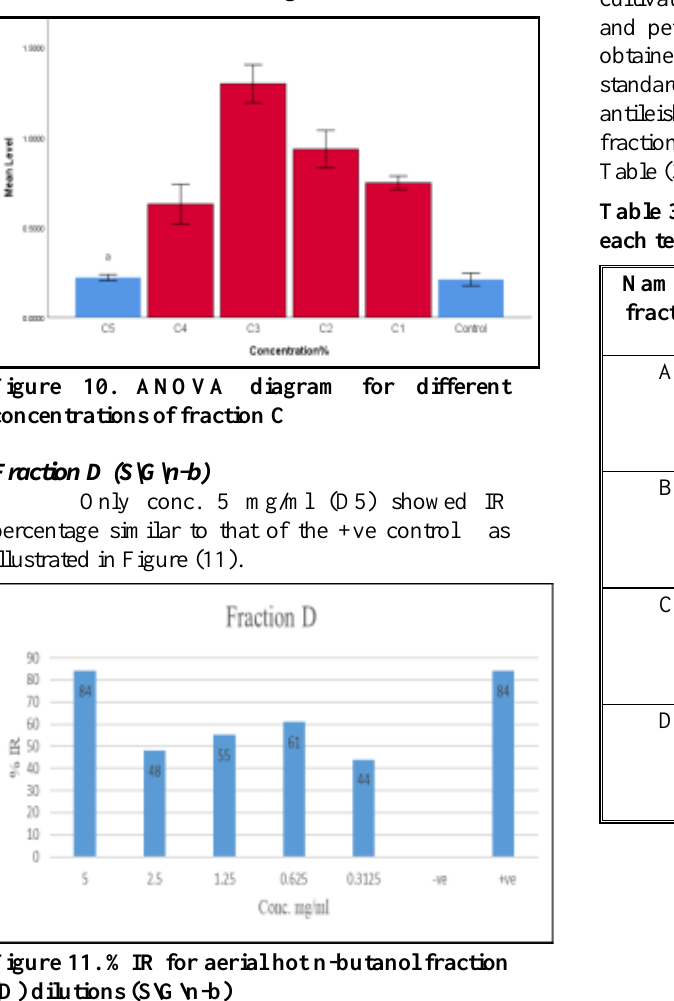
Figure 9. %IR for aerial maceration n-butanol fraction (C) dilutions (M\G\n-b) ANOVA analysis revealed non-significant mean difference between the C5 and that of the +ve control as illustrated in the Figure (10) .